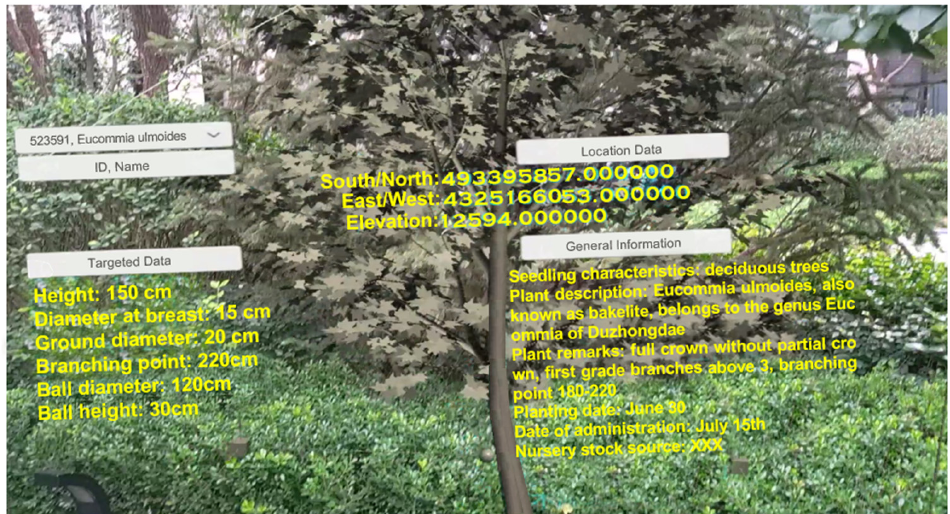
Figure 12. On-site model information